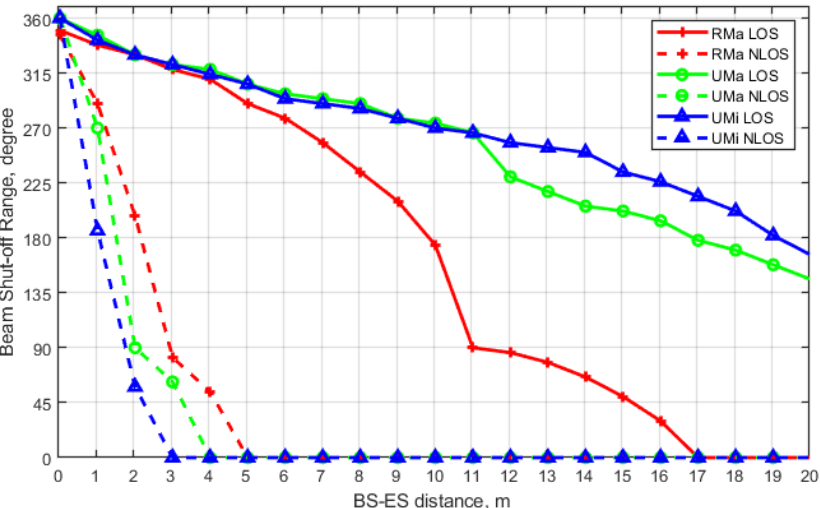
Figure 7. Beam shut-off angle vs. BS-ES distance (ES antenna elevation distance of 0 to 20 km and a 4 × 4 antenna array).